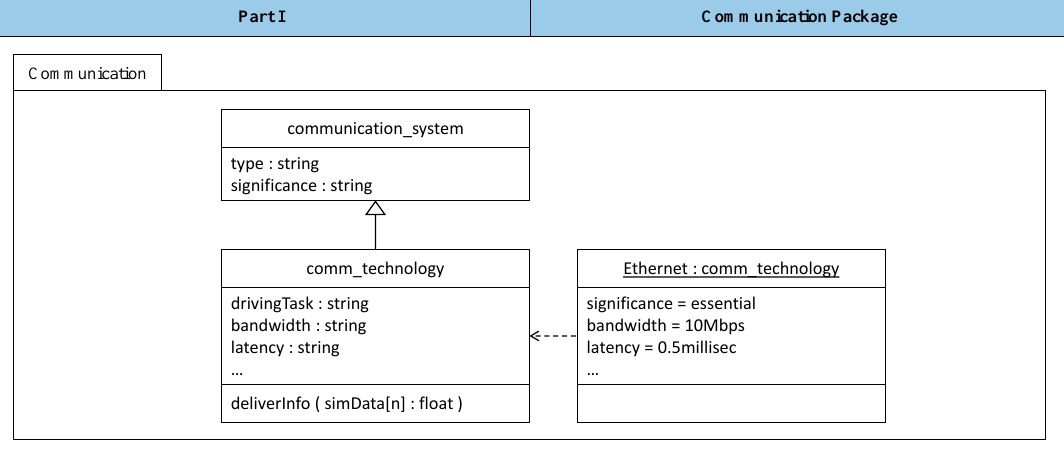
Figure 12. UML class diagram of the selected communication system components—package 2.